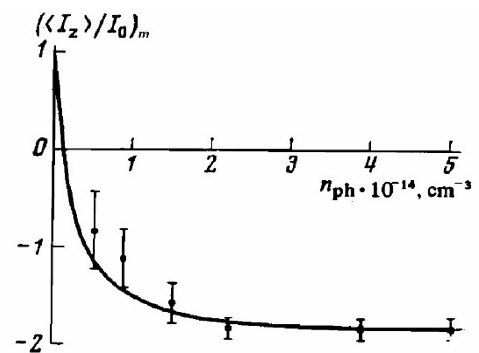
(cid:16) (cid:104) I (cid:17) (cid:105) z of the 29 Si nuclei as a function of the concentration n ph of 〈  〉  of the 29 Si nuclei as a function of the concentration n ph I 0 m